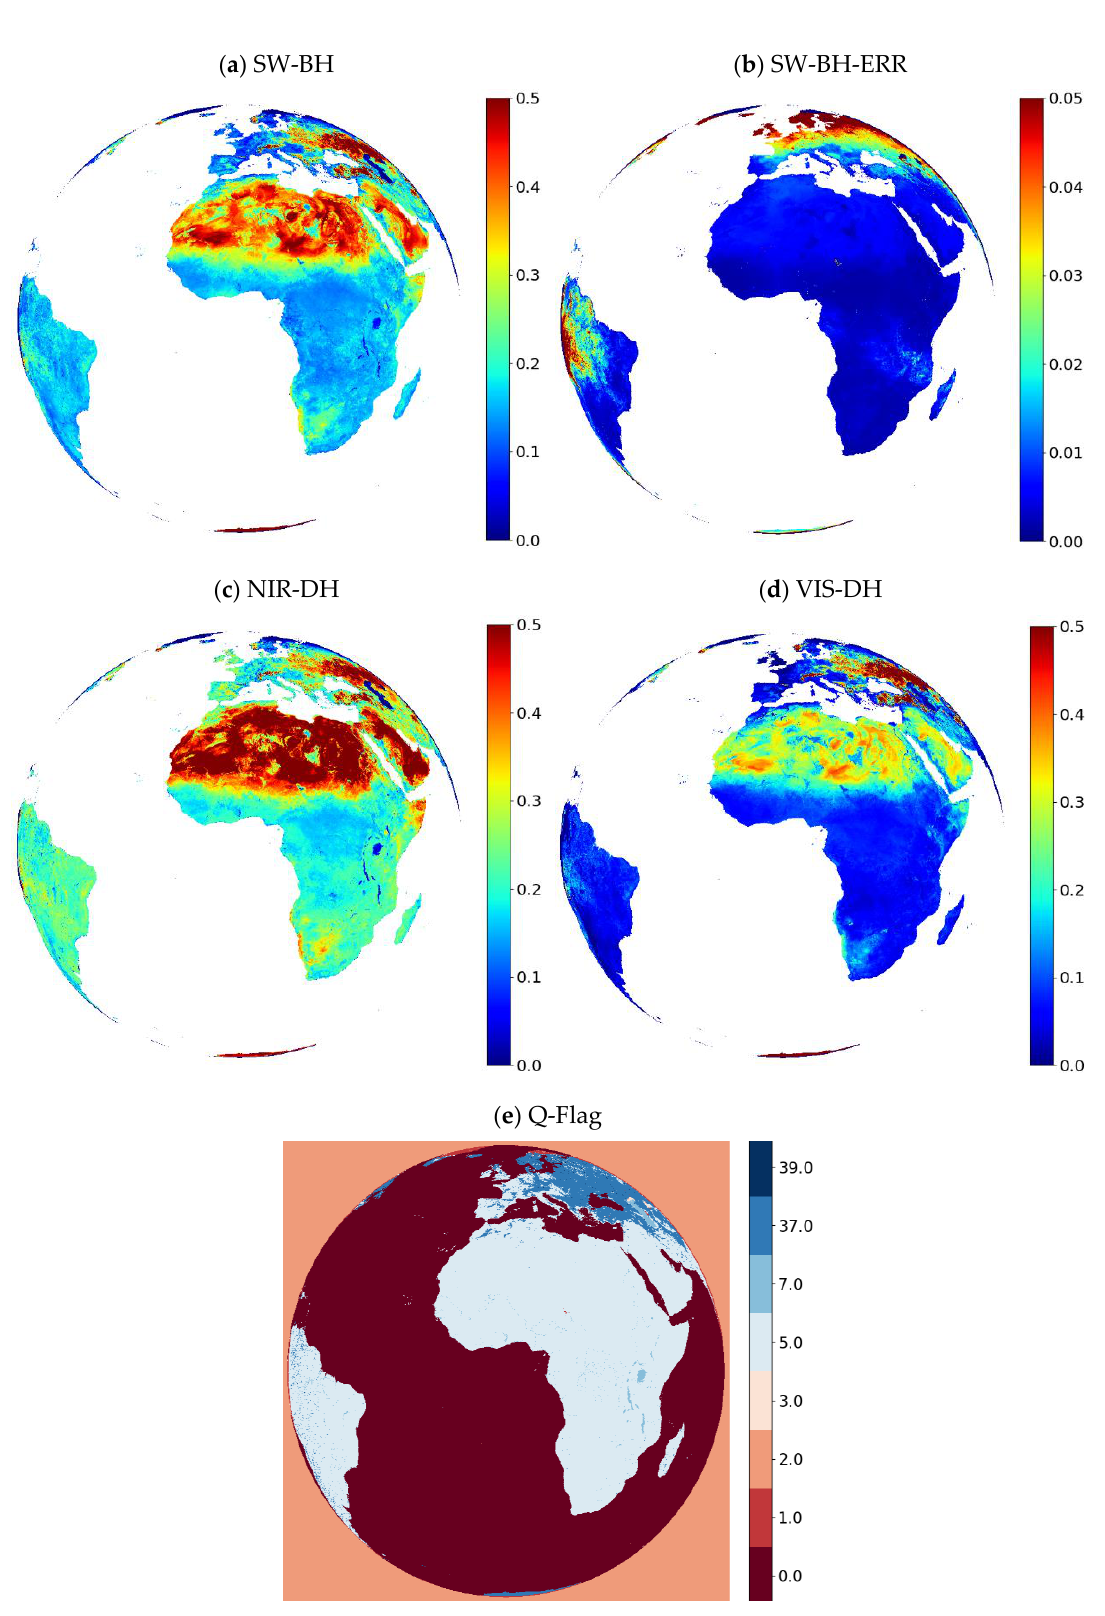
Figure 1. Broadband MTAL-R albedo for January 15, 2012: ( a ) Total short-wave bi-hemispherical (SW-BH); ( b ) total short-wave bi-hemispherical error (SW-BH-ERR); ( c ) near infrared directional-hemispherical (NIR-DH); ( d ) visible directional-hemispherical (VIS-DH); and ( e ) quality flag.